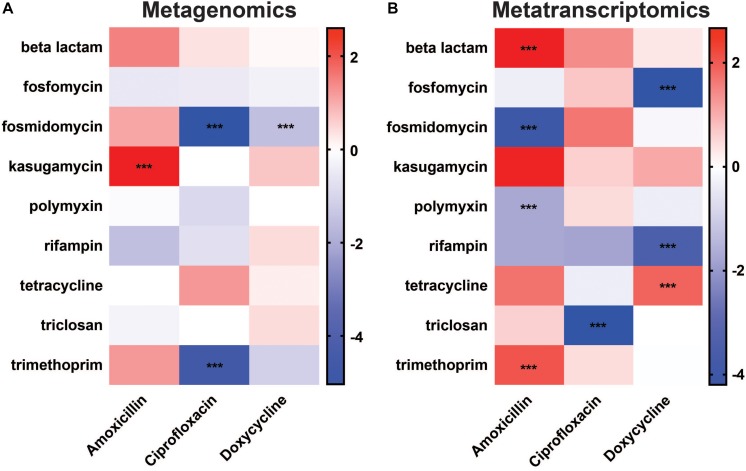
Differential abundance of antibiotic resistance gene classes. Changes in ARG class abundances after antibiotic treatment observed in (A) metagenomic and (B) metatranscriptomic data. The color scale represents log2 fold change (***log2FC ≥ 1.5/ ≤ –1.5 and padj < 0.05) (Full ARG class counts available in Supplementary Table S3).